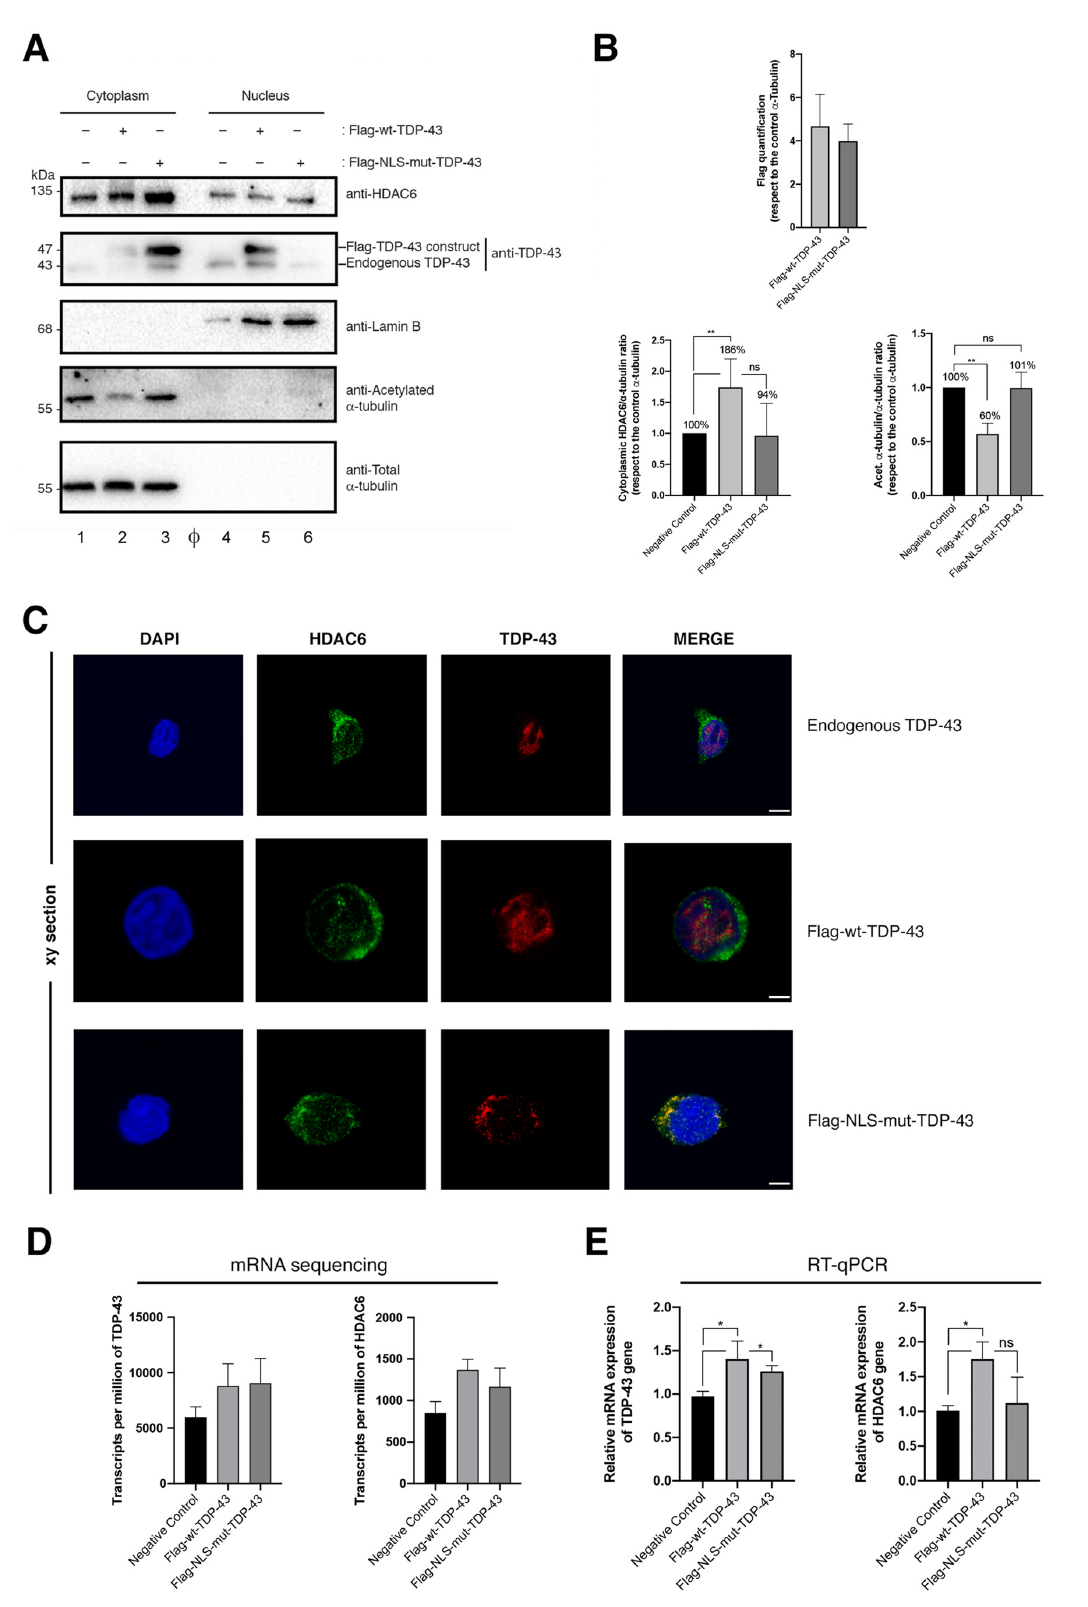
Figure 1. Overexpression of TDP-43 regulates HDAC6 mRNA and protein stability and favors its tubulin-deacetylation function. ( A ) Quantitative Western-blot analysis of cell fractioning from